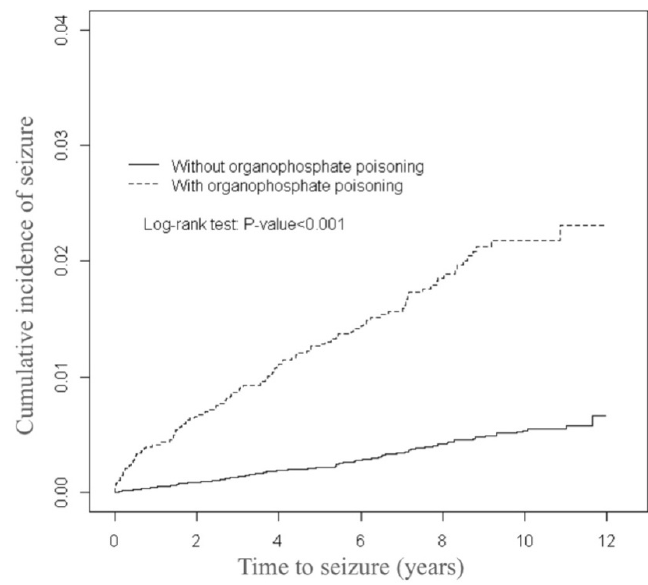
Figure 1. Comparison of the cumulative incidence of seizures among patients with and without organophosphate poisoning.